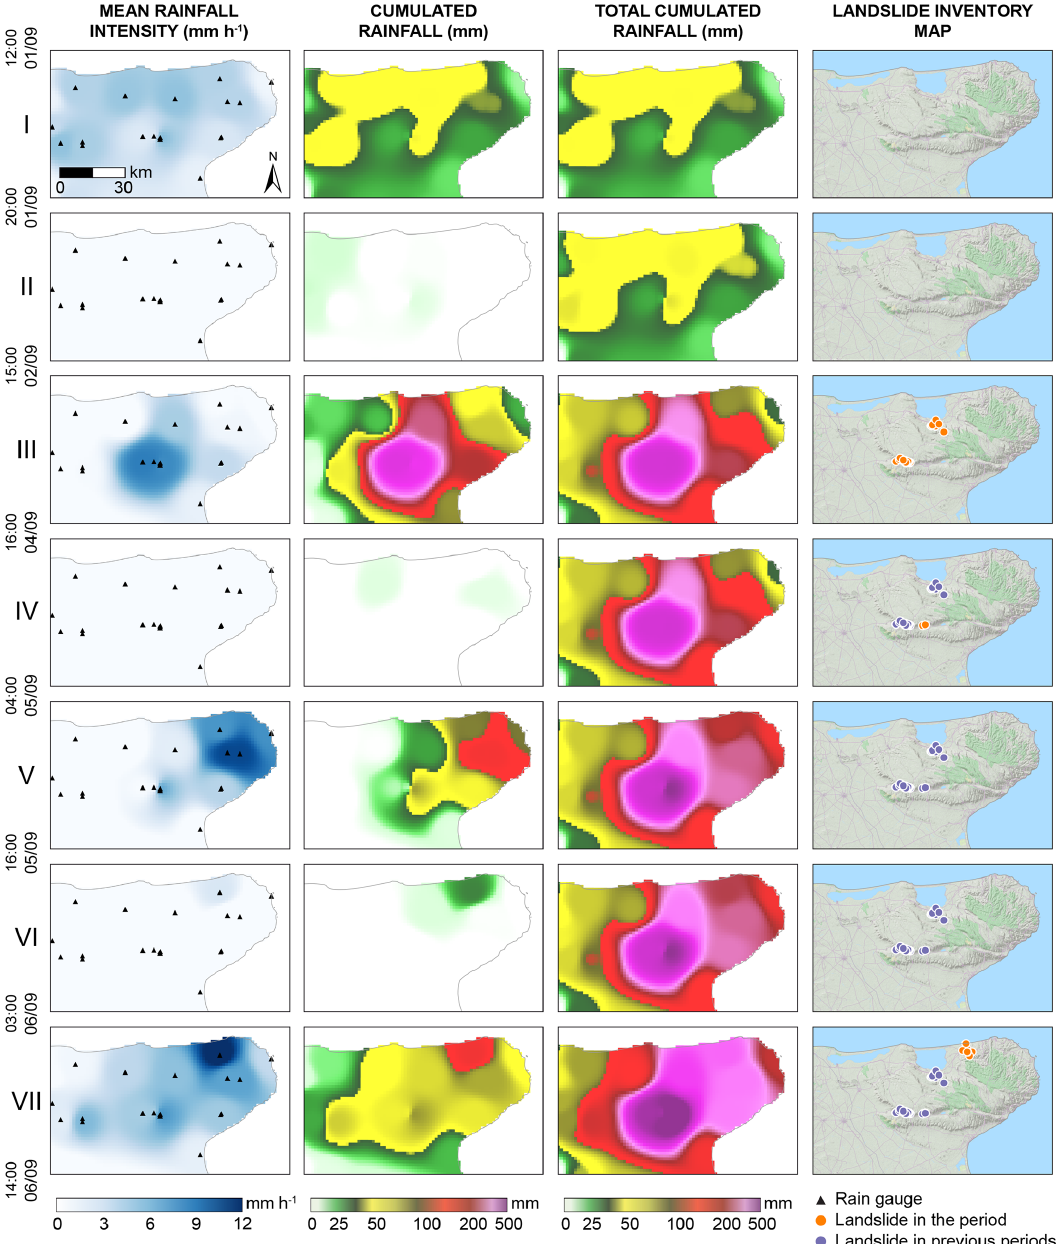
Figure 7. Analysis of the spatial and temporal distribution of the event rainfall and of the triggered event landslides. See text for